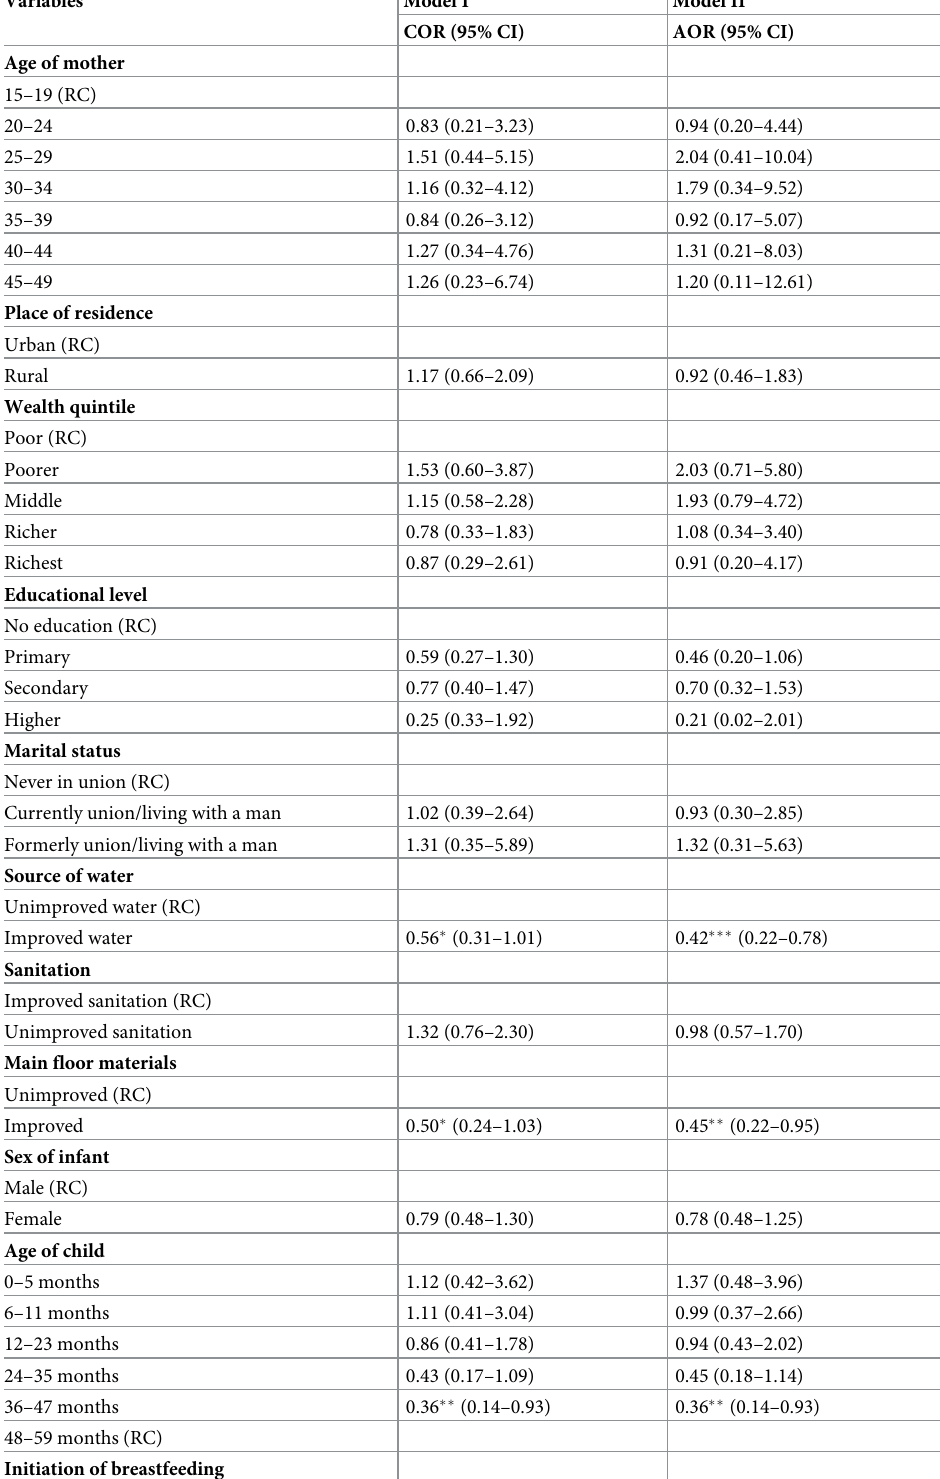
Table 4. Binary logistics regression showing the factors associated with